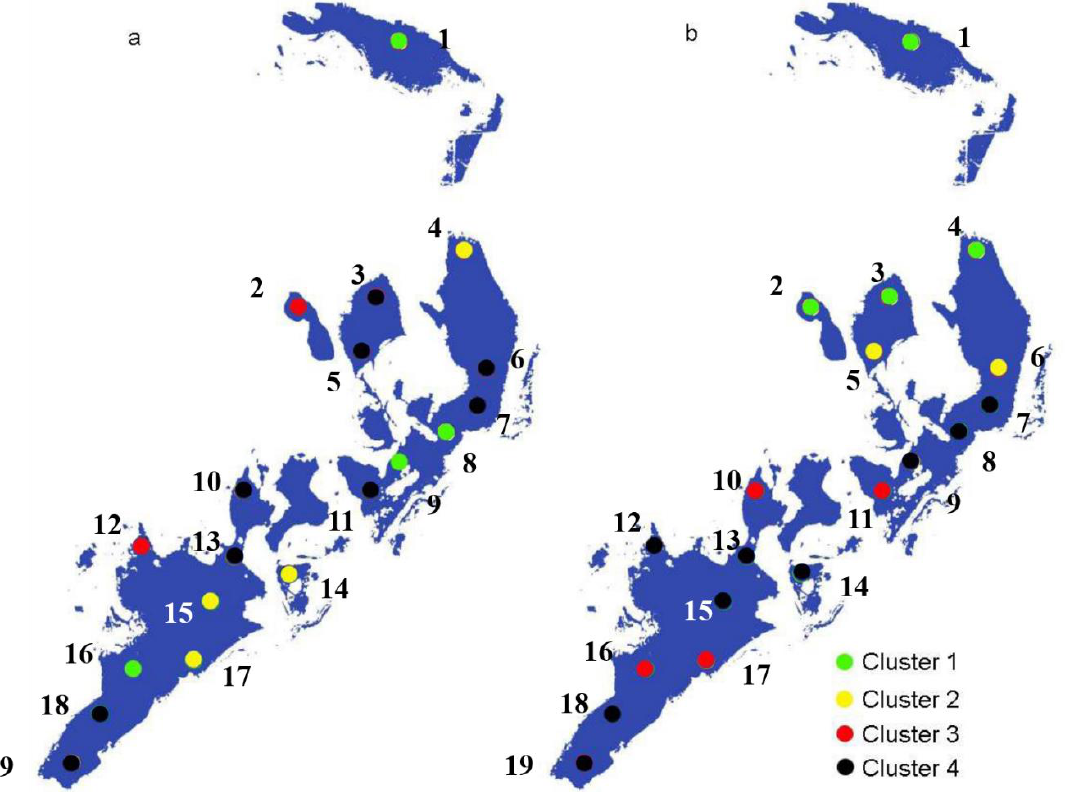
Figure 3. The clustering distribution of sampling points (Ward’s method) based on the HCA results between the irrigation period ( a ) and non-irrigation period ( b ).